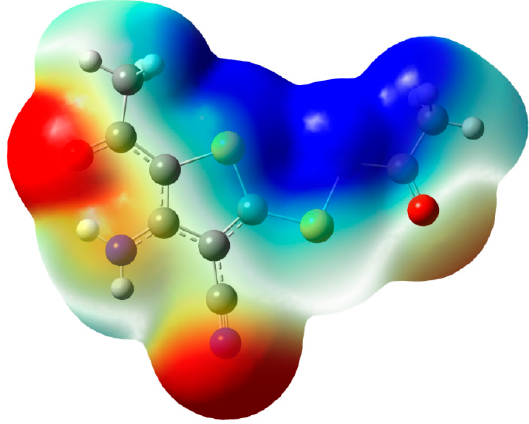
Figure 4. Molecular Electrostatic potentials (MEP) mapped on the electron density surface calculated by the DFT/B3LYP method.